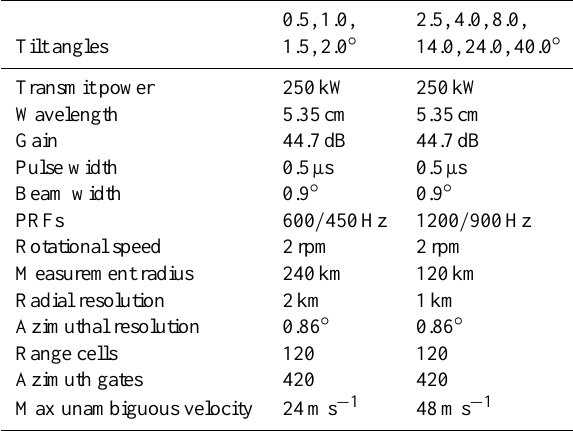
Table 1. Selected characteristics of the Swedish weather